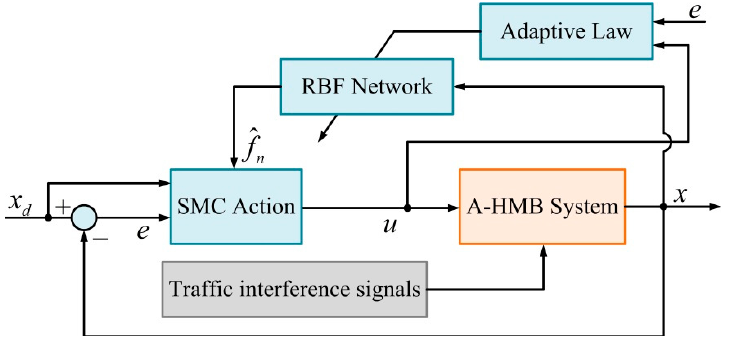
Figure 4. Block diagram of the overall control scheme of A-HMB system.